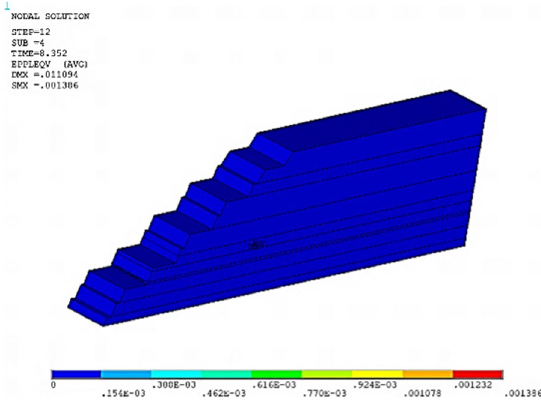
Fig. 21 Cloud diagram of the plastic strain of the slope global